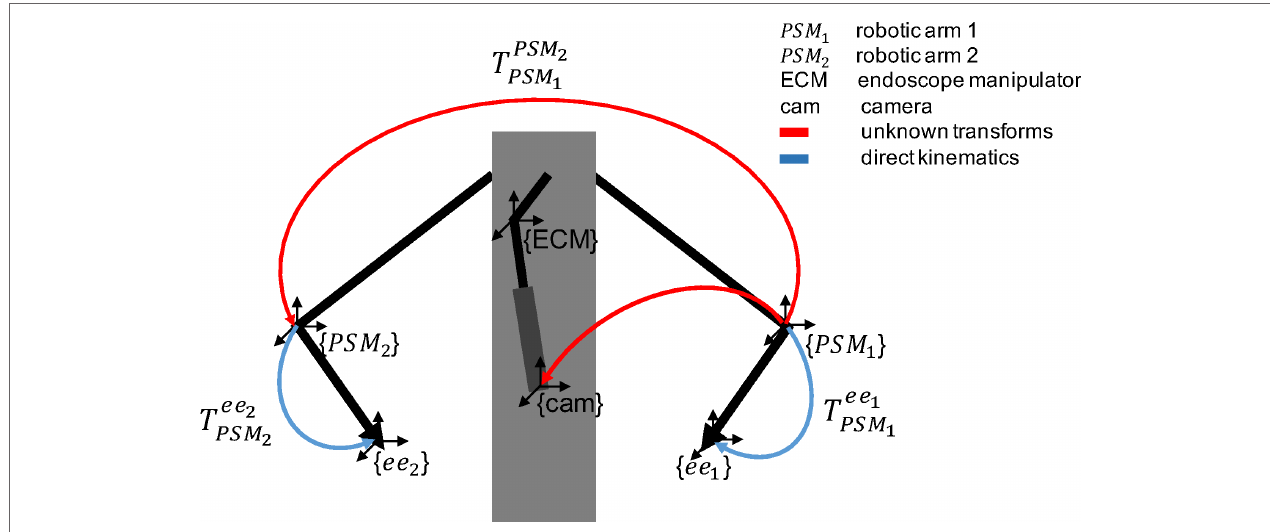
FigUre 2 | Overview of the reference systems of the da Vinci robotic arms . The blue arrows represent the pose of the two arms ( PSM 1 and PSM 2 ) given by direct kinematics. The red arrows represent unknown transforms: (i) between PSM 1 and PSM 2 (ii) between PSM 1 and cam , computed as described in Sec.